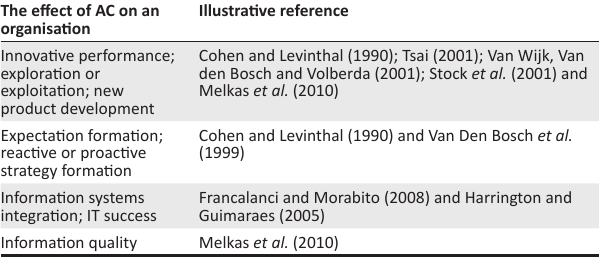
TABLE 2: Effects of absorptive capacity (AC) on organisations (own).